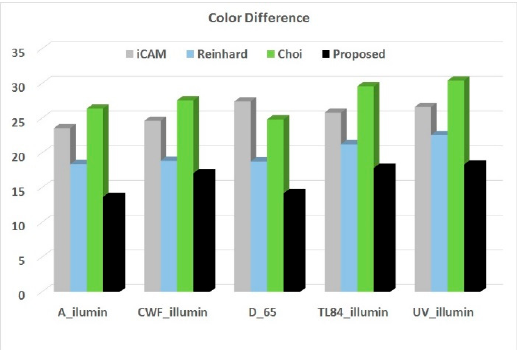
Figure 11. CIEL*a*b*-based color difference ( ∆ E_ab) comparison between the conventional and proposed tone mapping methods with the captured images under five different standard illuminations.